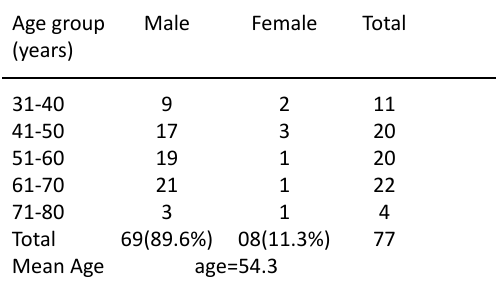
Table 2. Localization of oral alterations in Head and Neck Cancer and Control Localization